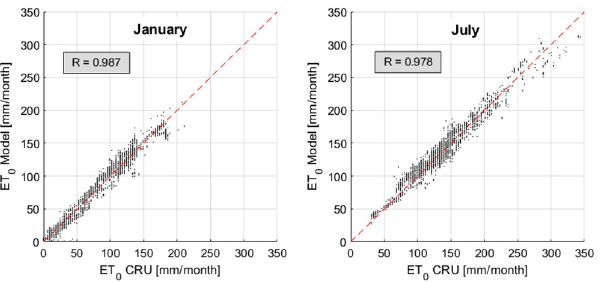
Fig 1. Comparison between the CRU-TS v.4 ET 0 (Penman-Monteith, monthly data) and the monthly average ERA5-based Hargreaves-Samani ET 0 . The comparison was made considering all the cells around the world where the harvested area is at least 90% of the pixel, for the months of January (a) and July